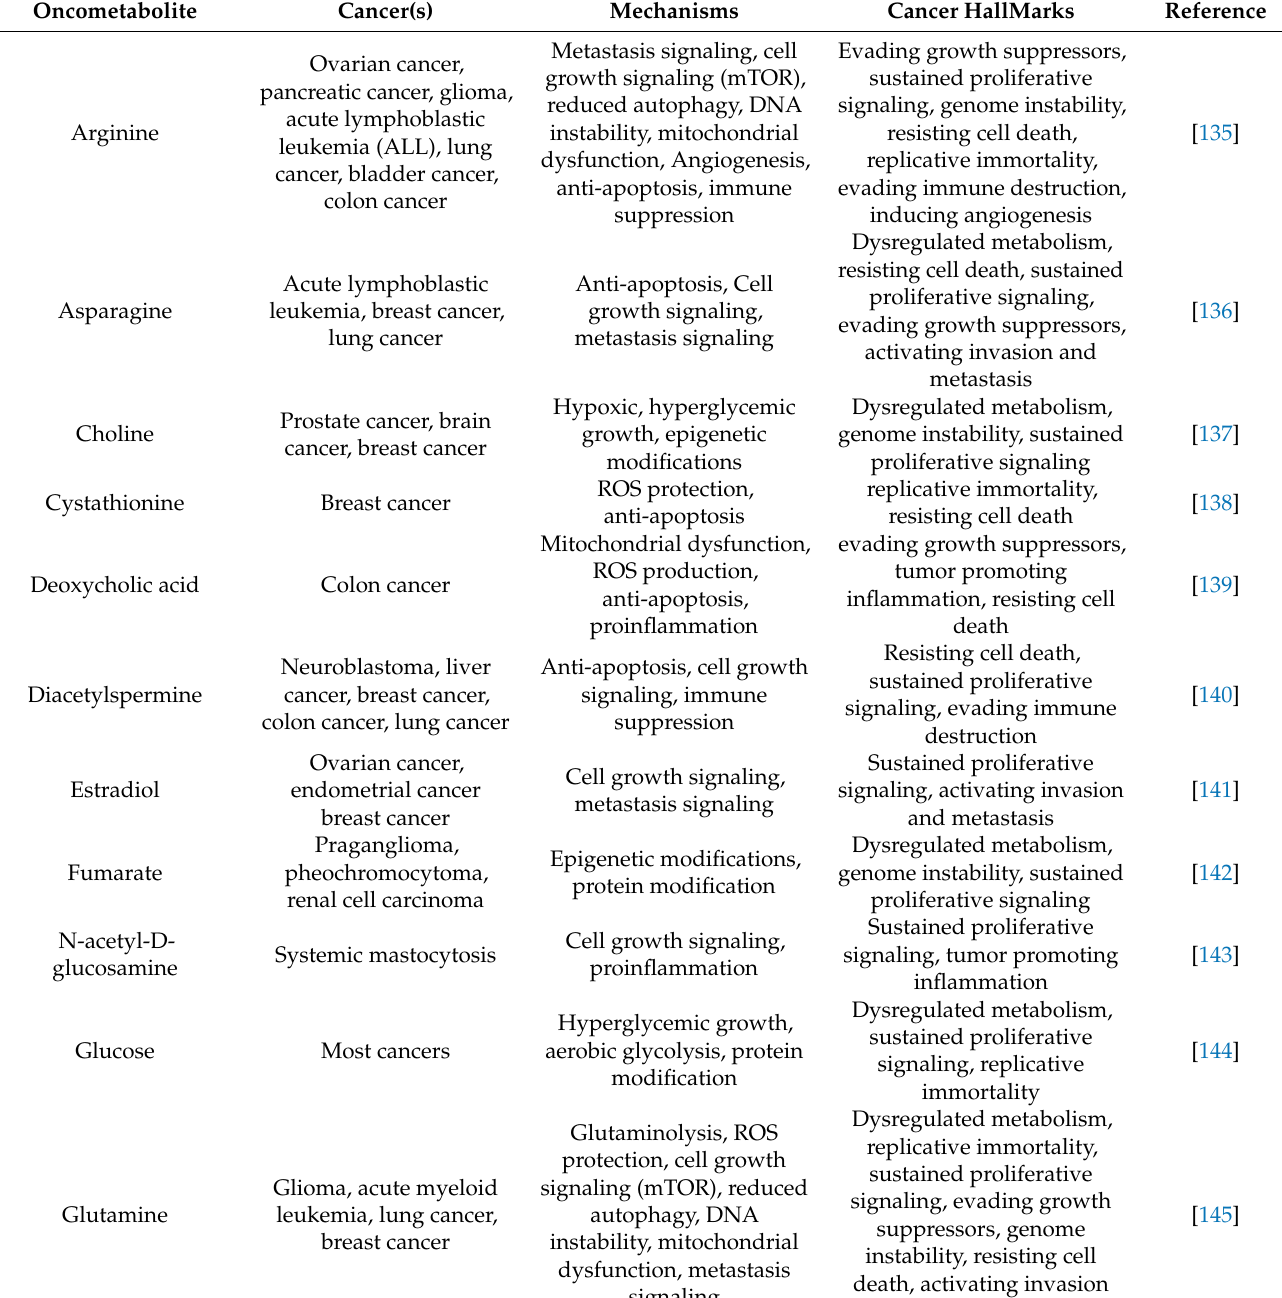
Table 3. Oncometabolites (traditional and non-traditional), their associations with different cancers, their mechanisms, and cancer hallmark